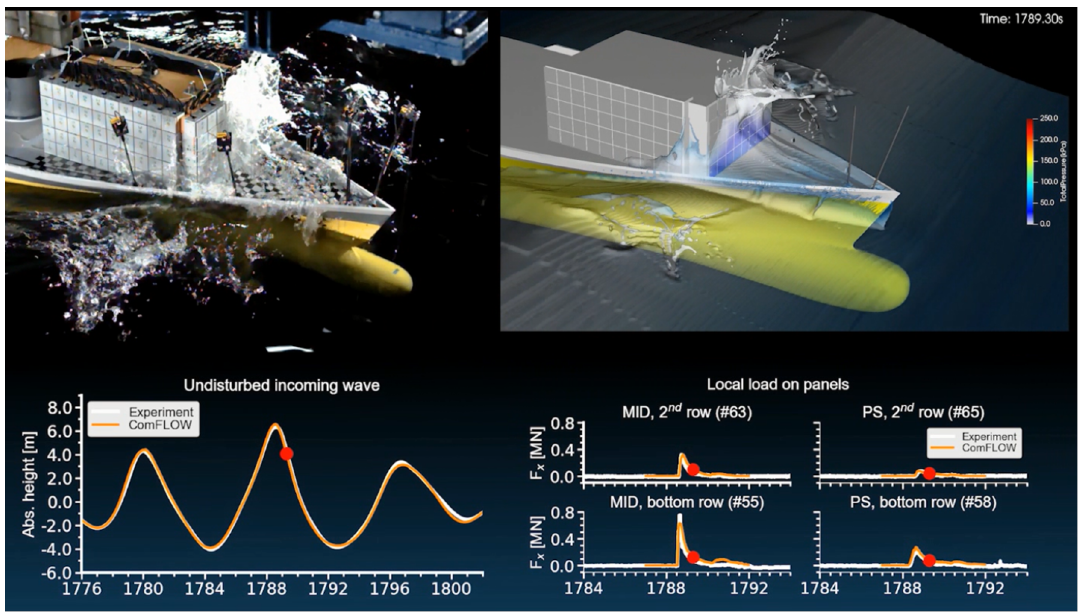
Figure 5. Synchronised green water event during the experiment ( left ) and in the CFD calculation ( right ), with the associated undisturbed wave elevation at the bow location and forces on four of the breakwater panels. Figure based on the same data as a figure in